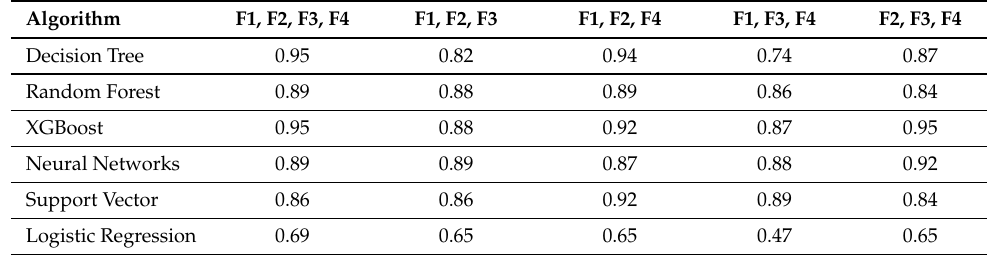
Table 1. Balanced Accuracy Result Comparison.